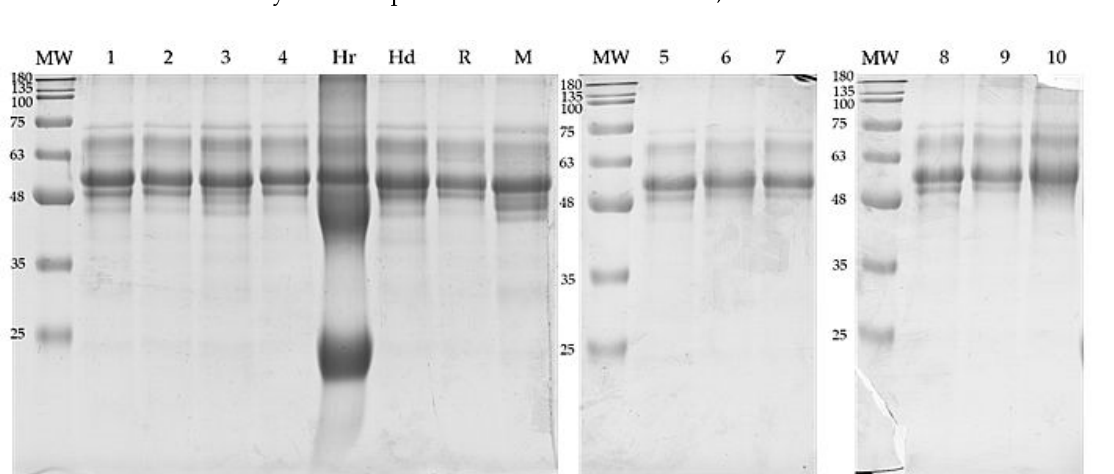
Figure 1. Color analysis of goldenrod honey samples (1–10). Different letters above the bars indi- cate significant differences ( p = 0.05).